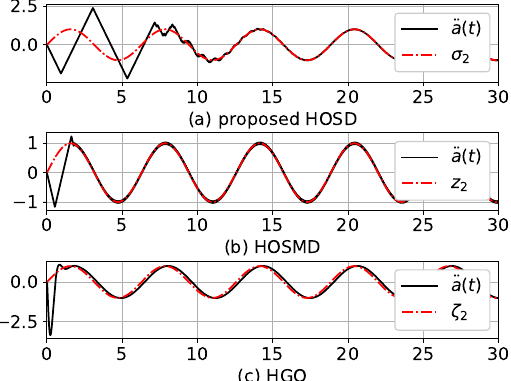
Figure 3. Estimations of ¨ a using parameter set 1 (cid:13) in Table 1.